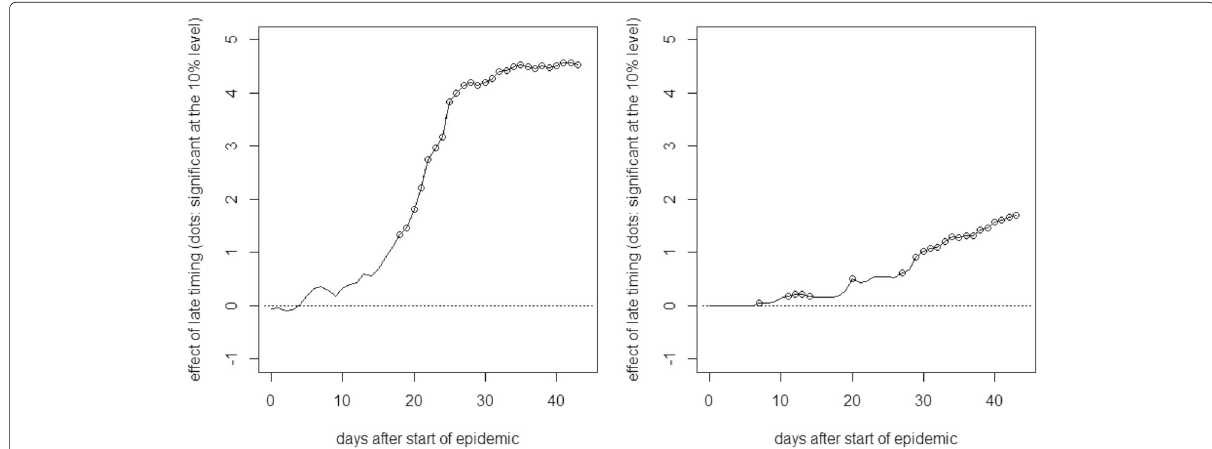
Fig. 9 Effect of late timing of measures on cumulative hospitalizations (left) and deaths (right) per 10,000 inhabitants in